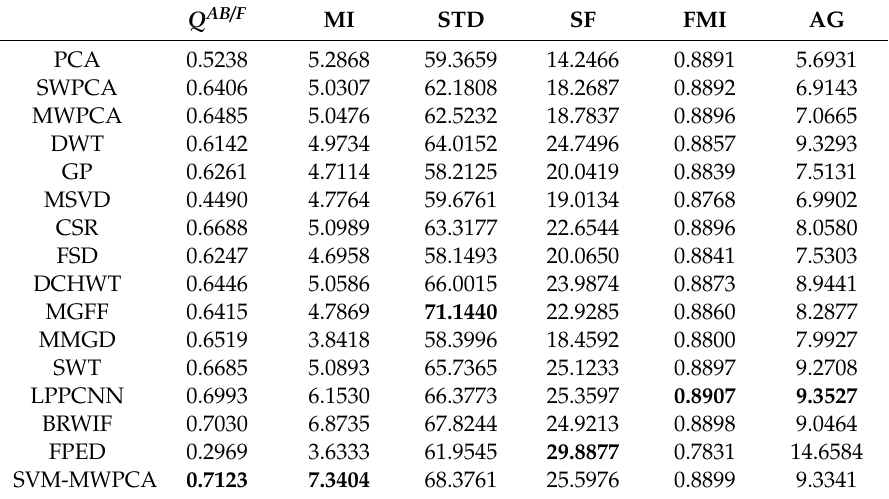
Table 2. Evaluation indexes of the fused images in source image pair “o ffi ce”. Q AB / F